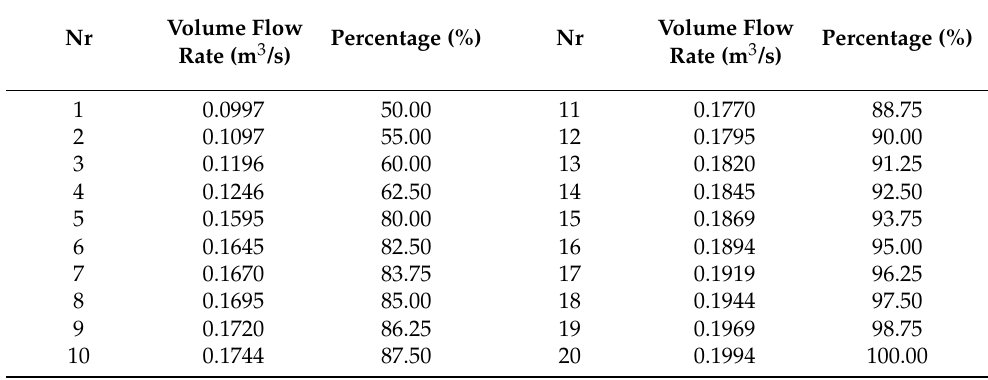
Table 3. Measurement points.